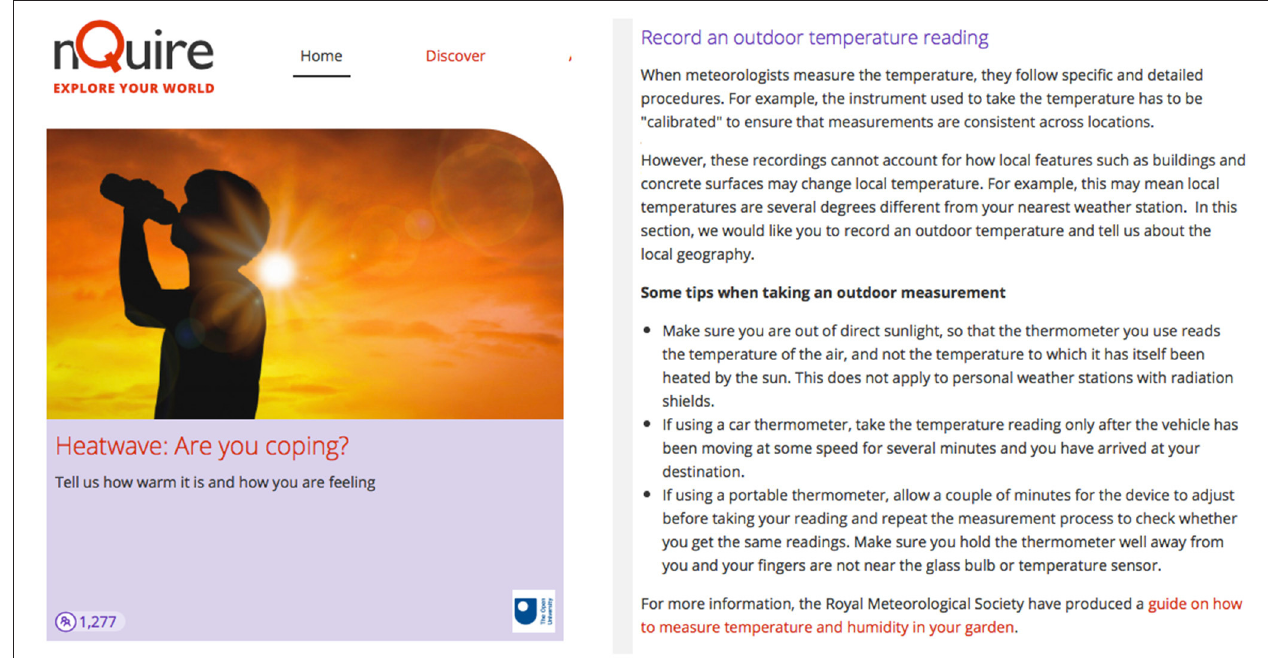
FIGURE 4 | Instructions about how to measure temperature in the Heatwave: Are you coping? mission.